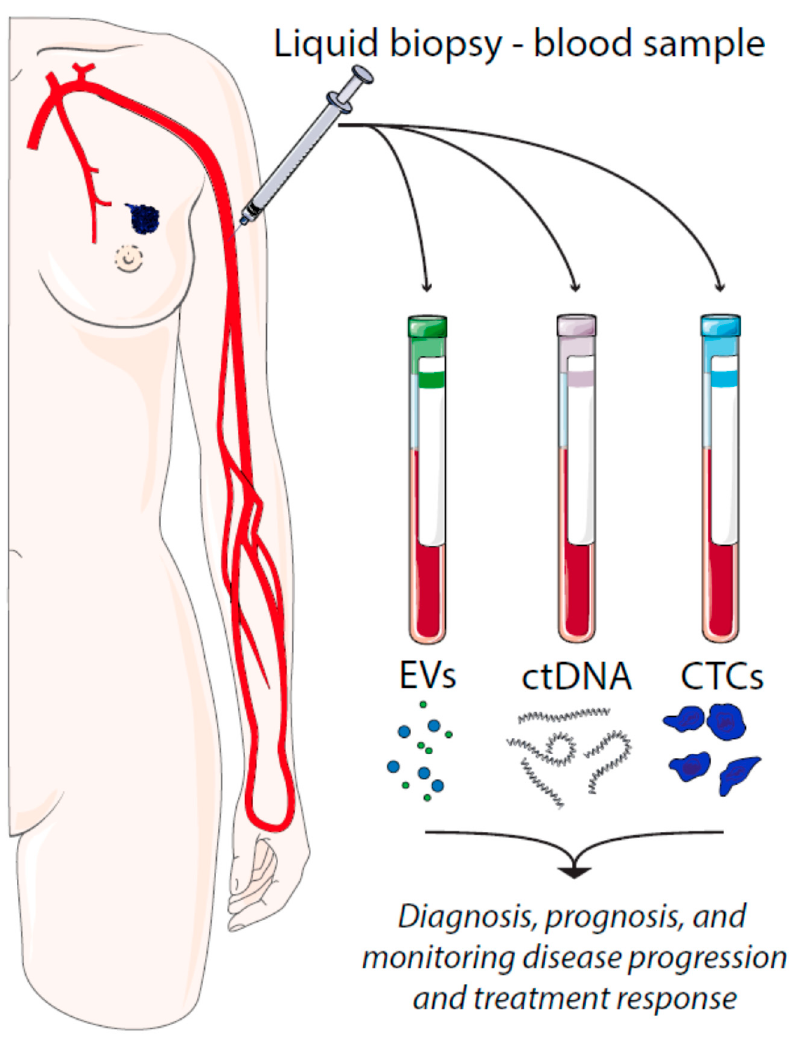
Figure 1. Liquid biopsies in breast cancer and their utilities. EV = extracellular vesicles, ctDNA = circulating tumor DNA, CTCs = circulating tumor